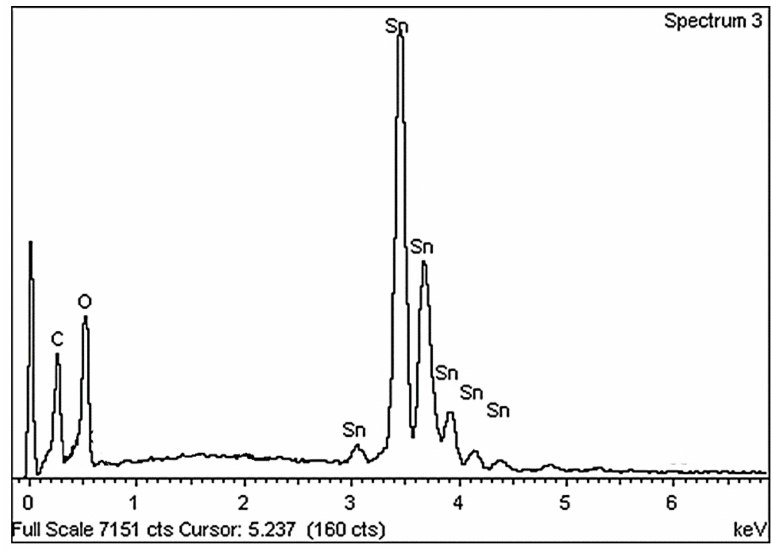
Figure 4. Nanoparticle EDX spectrum at 600 ◦ C